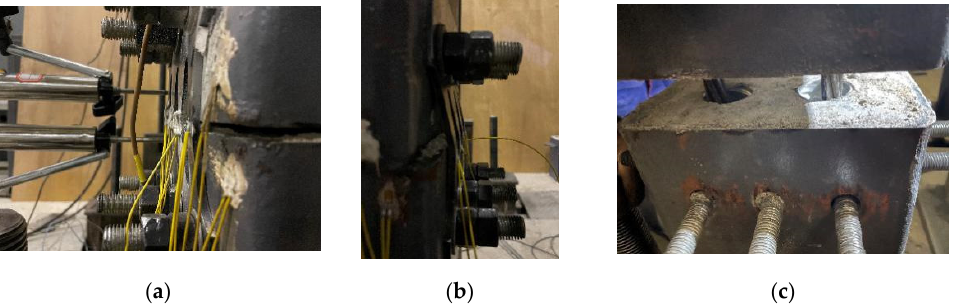
Figure 14. Deformation and concrete of energy-consuming elements, ( a ) Offset rate 2.2%, ( b ) Offset rate 6.2%, ( c ) Inner concrete intact after loading.